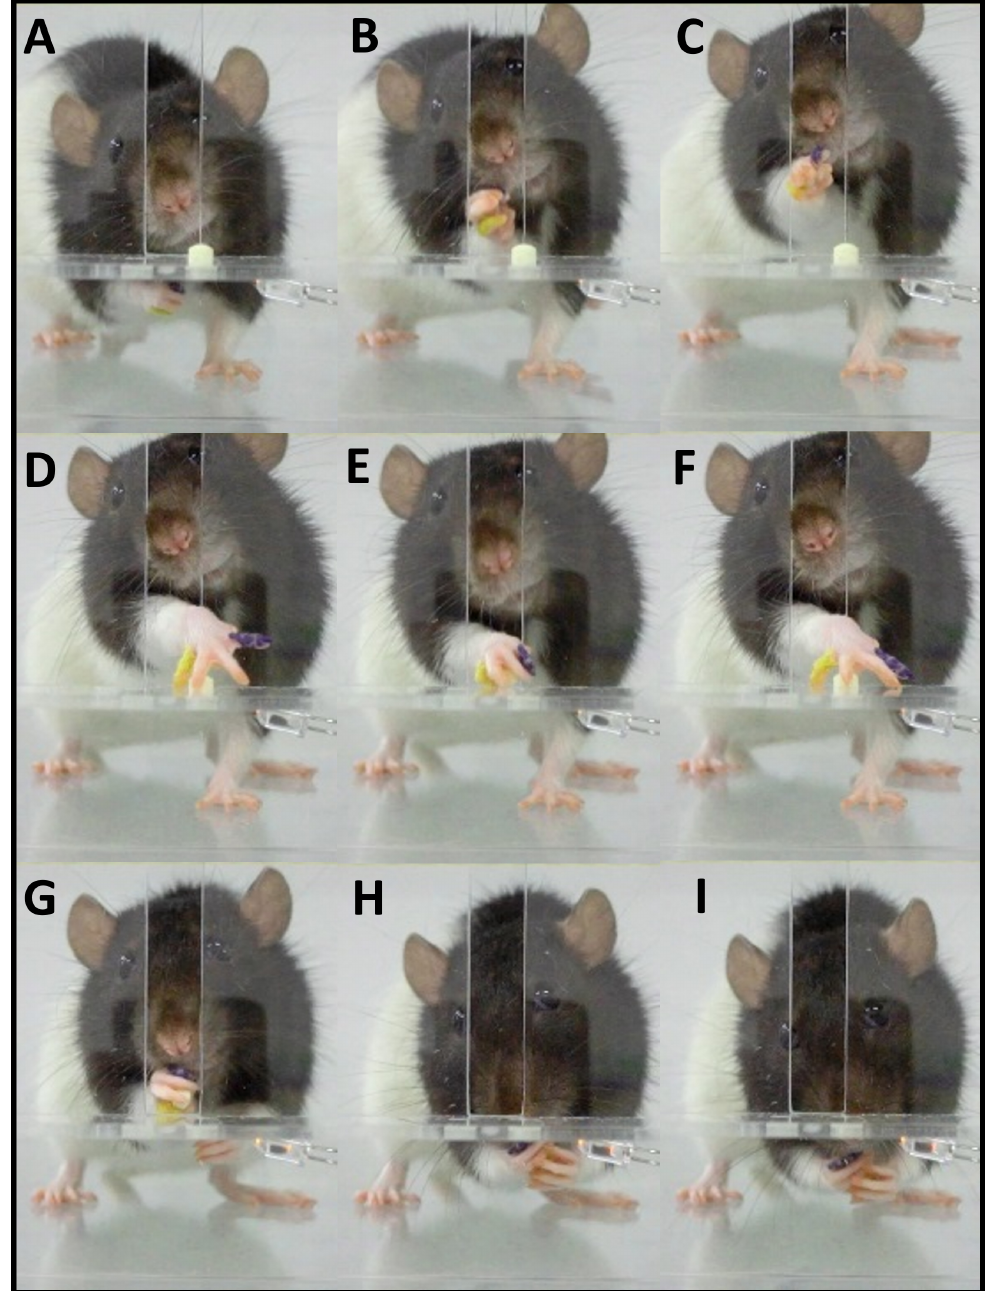
Fig. 1. Motor elements of the reaching task (RT). (A) Fingers to midline (Element 1). (B) Fingers semiflexed (Element 2) and Elbow to midline (Element 3). (C) Advance (Element 4). (D) Fingers extend (Element 5). (E) Pronation (Element 6). (F) Grab (Element 7). (G) Supination 1 (Element 8). (H) Supination 2 (Element 9). (I) Release (Element